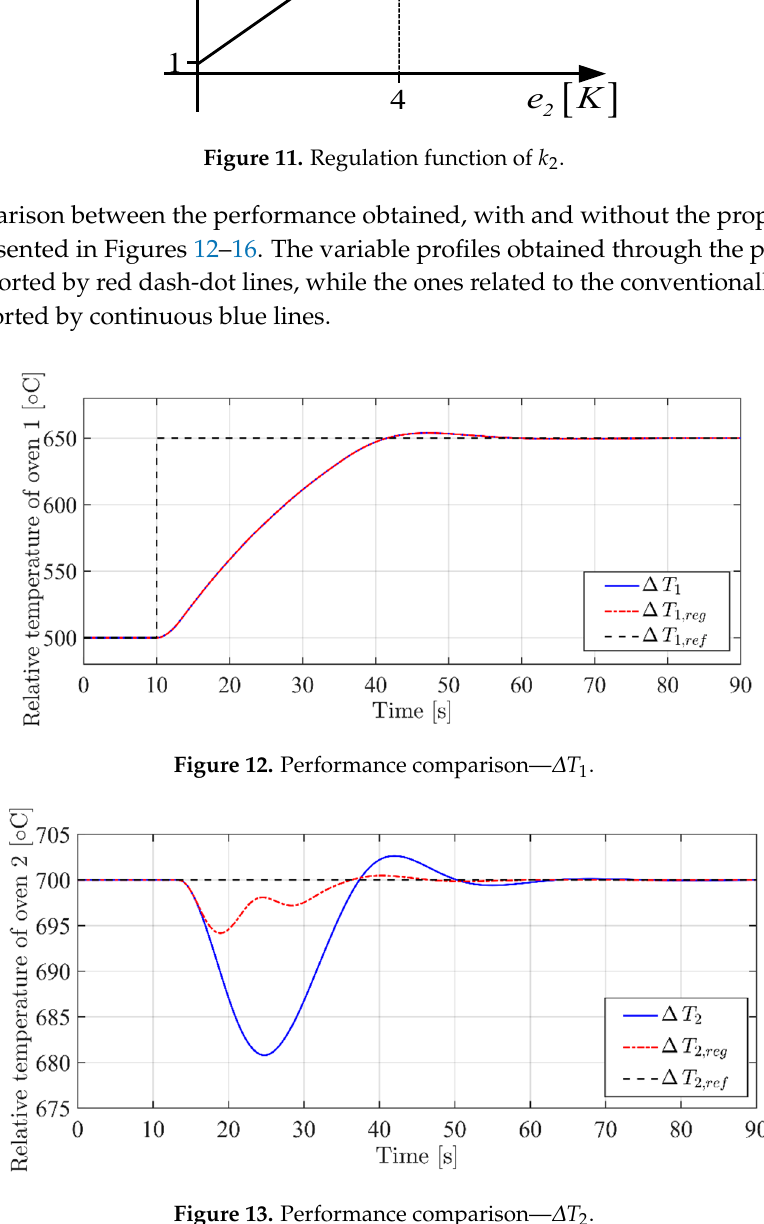
Figure 11. Regulation function of 𝑘 (cid:2870)